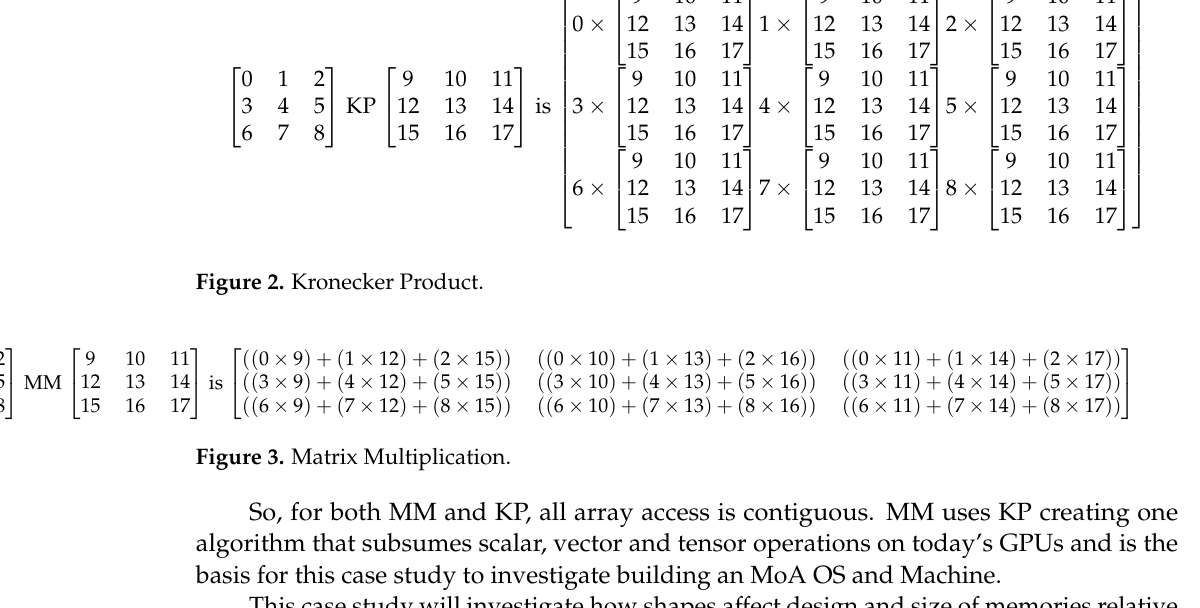
Figure 2. Kronecker Product.